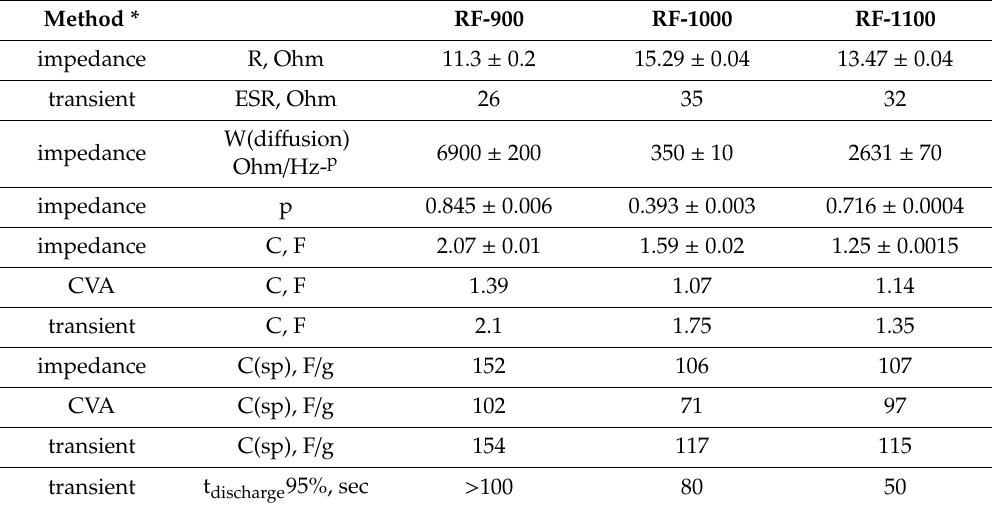
Table 3. The basic electrochemical properties of samples, prepared with di ff erent temperatures. Method * RF-900 RF-1000 RF-1100 impedance R, Ohm 11.3 ± 0.2 15.29 ± 0.04 13.47 ± 0.04 transient ESR, Ohm 26 35 32 W(di ff usion) 6900 ± 200 350 ± 10 2631 ± 70 impedance Ohm / Hz- p impedance p 0.845 ± 0.006 0.393 ± 0.003 0.716 ± 0.0004 impedance C, F 2.07 ± 0.01 1.59 ± 0.02 1.25 ± 0.0015 CVA C, F 1.39 transient C, F 2.1 impedance C(sp), F / g 152 106 107 CVA C(sp), F / g 102 71 97 transient C(sp), F / g